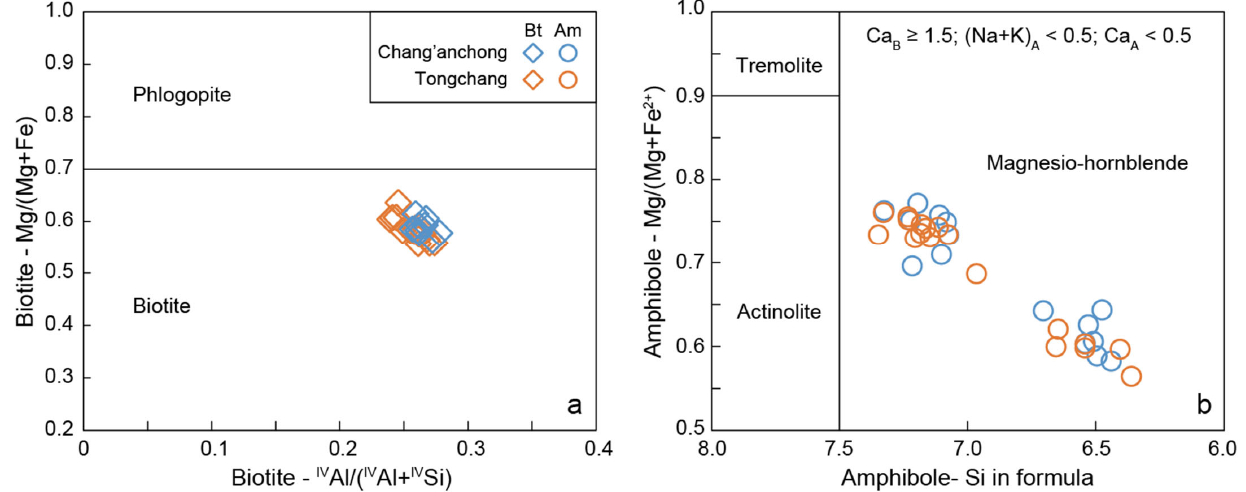
Figure 4. Illustrations of biotite and amphibole compositions from Tongchang and Chang’anchong quartz syenite porphyries. ( a ) Plots in Mg/(Mg + Fe) vs. IV Al/( IV Al + IV Si) binary diagram for biotite (after [58]); ( b ) Plots in Si in formula vs. Mg/(Mg + Fe 2+ ) binary diagram for amphibole (after [62]).